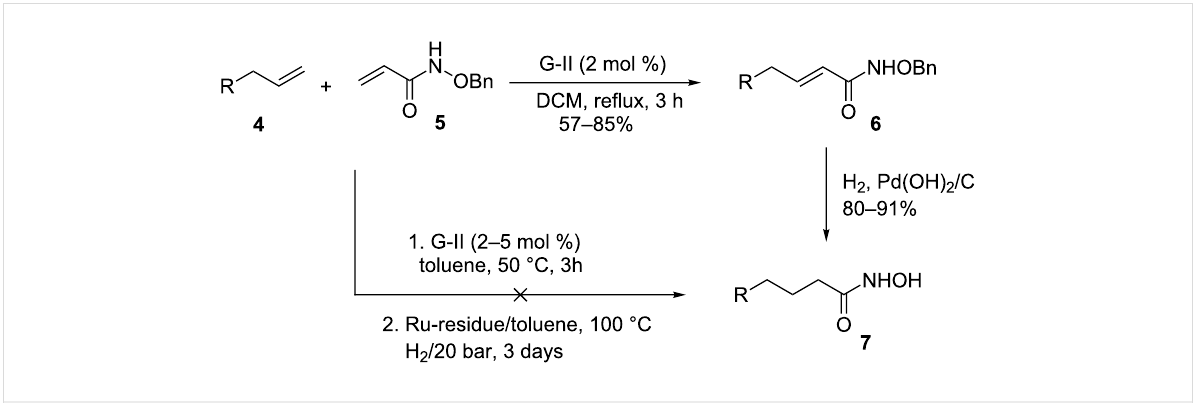
Scheme 1: Cross metathesis between a class-I alkene and N -benzyloxyacryl amide.